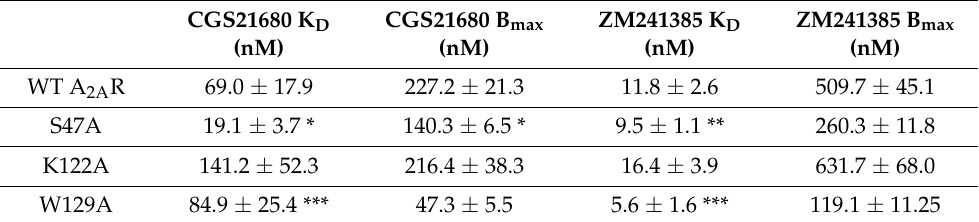
Figure 2. Specific ligand binding of CCM A 2A R variants. ( A ) Specific binding of increasing concentrations of [ 3 H] CGS21680 to membrane preparations from cells expressing WT A 2A R (filled circles), S47A (open squares), K122A (filled triangles), or W129A (open circles). Mean ± S.D. values from n ≥ 2 experiments performed in duplicate. ( B ) Specific binding of increasing concentrations of [ 3 H]ZM241385 to membrane preparations from cells expressing WT A 2A R (filled circles), S47A (open squares), K122A (filled triangles), or W129A (open circles). Mean ± S.D. values from n ≥ 2 experiments performed in duplicate. Lines indicate the fit of a one-one binding model for the data (kinetic parameters listed in Table 1; WT A 2A R, solid line; S47A, dashed; K122A, dotted; or W129A, dash-dotted. Table 1. Ligand binding parameter fits for a one-one model of receptor to ligand. K D and B max values reported as best fit ± S.E. from data shown in Figure 2. * Indicates p < 0.01, ** indicates p < 0.001, *** indicates p =